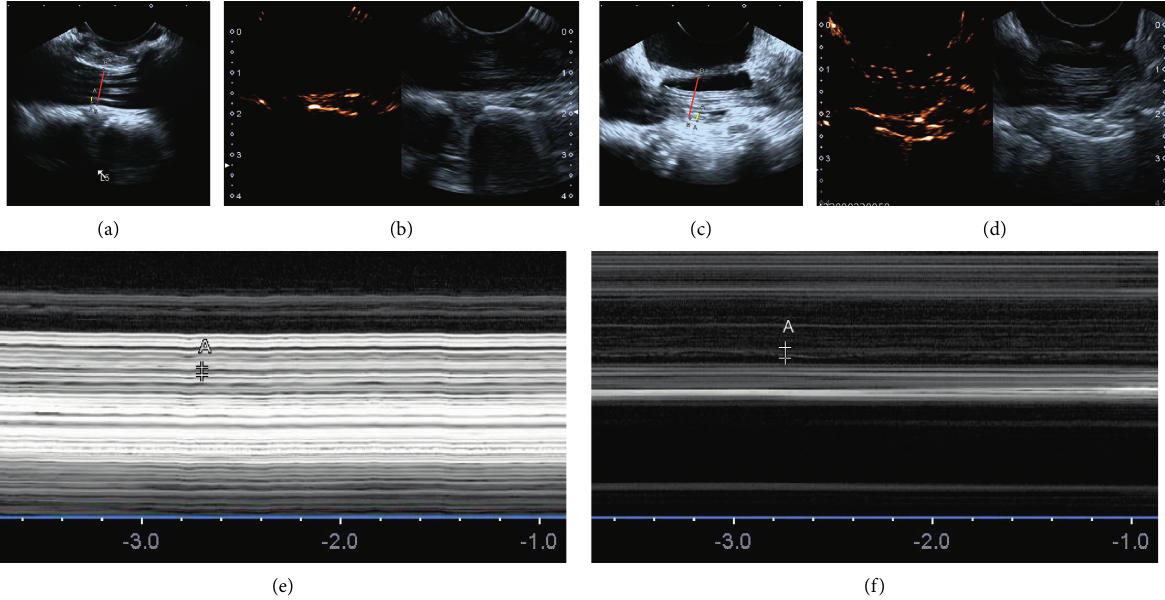
Figure 6: Intraoperative ultrasonography (IoUS) of the case: (a) preoperative diameter of the L5 nerve root (yellow line) and dura mater (red line); (b) preoperative blood perfusion of the L5 nerve root (white arrow); (c) postoperative diameter of the L5 nerve root (yellow line) and dura mater (red line); (d) postoperative blood perfusion of the L5 nerve root (white arrow); (e) preoperative amplitude of the L5 nerve root; and (f) postoperative amplitude of the L5 nerve